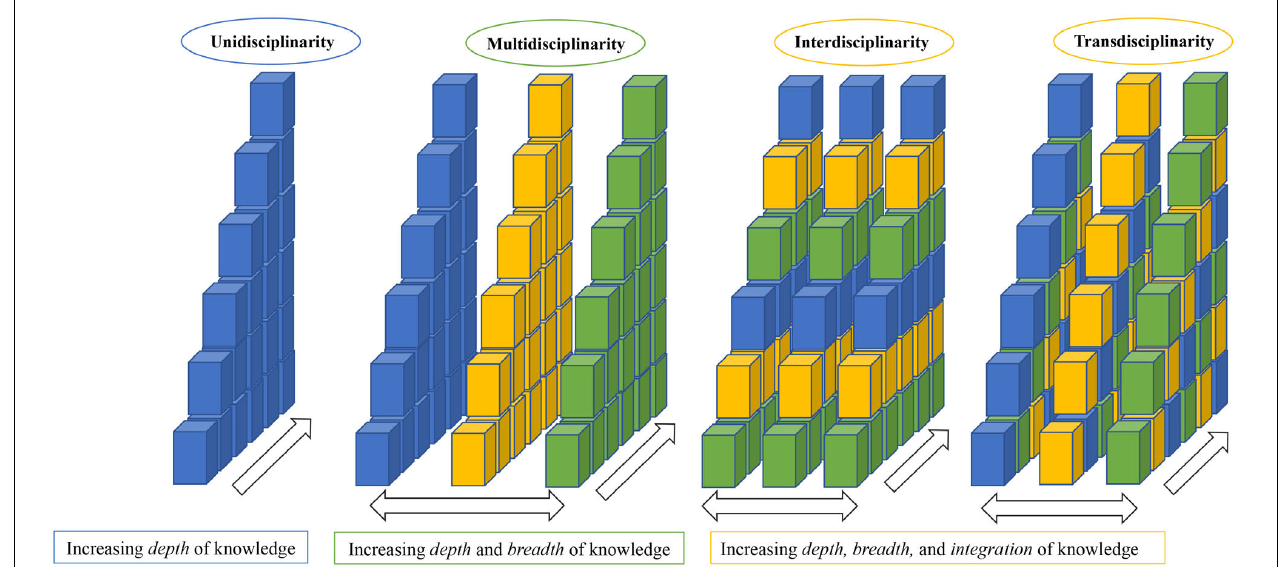
FIGURE 3 | Convergence requirements: depth, breadth, and integration of knowledge.